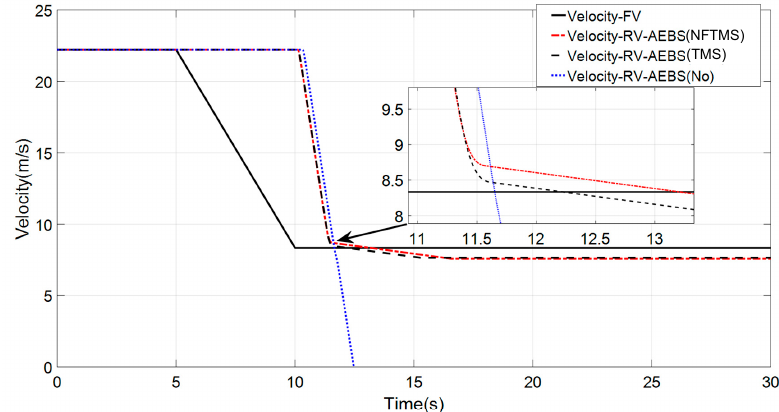
Figure 2. Comparison of relative speed.